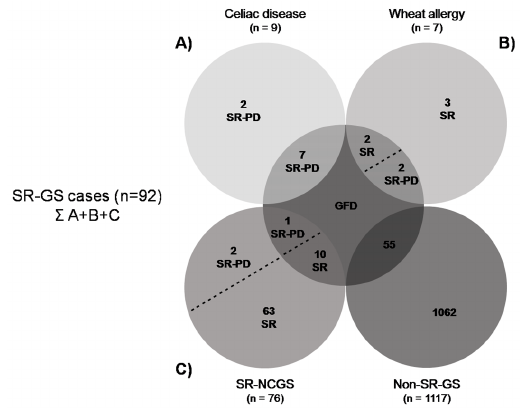
Figure 1. Characteristics of respondents following a GFD. SR: self ‐ reported; SR ‐ NCGS: self ‐ reported non ‐ celiac gluten sensitivity; Non ‐ SR ‐ GS: non self ‐ reported gluten sensitivity; SR ‐ PD: self ‐ reported physician ‐ diagnosed. ( A – C ) SR ‐ celiac disease, SR ‐ wheat allergy and SR ‐ NCGS cases either following a GFD or not. Only those cases that reported adherence to a GFD were considered for